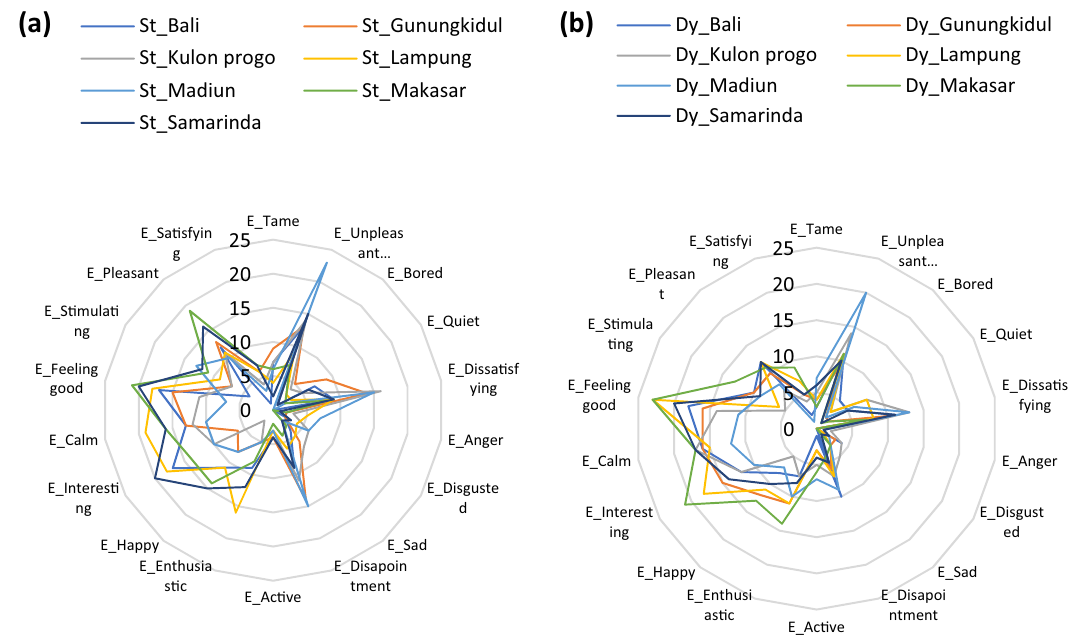
Figure 2: Emotional conceptualisations segmented according to the emotional eating behaviour: ( a ) Chocolate processed using the static roasting ( St ) . ( b ) Chocolate processed using the dynamic roasting ( Dy )